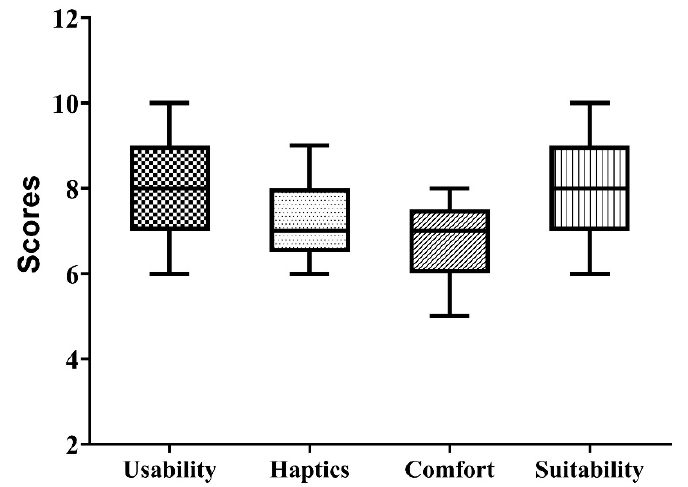
Figure 6. Result of neurosurgeon’s survey-based evaluation of the developed craniotomy simulator.